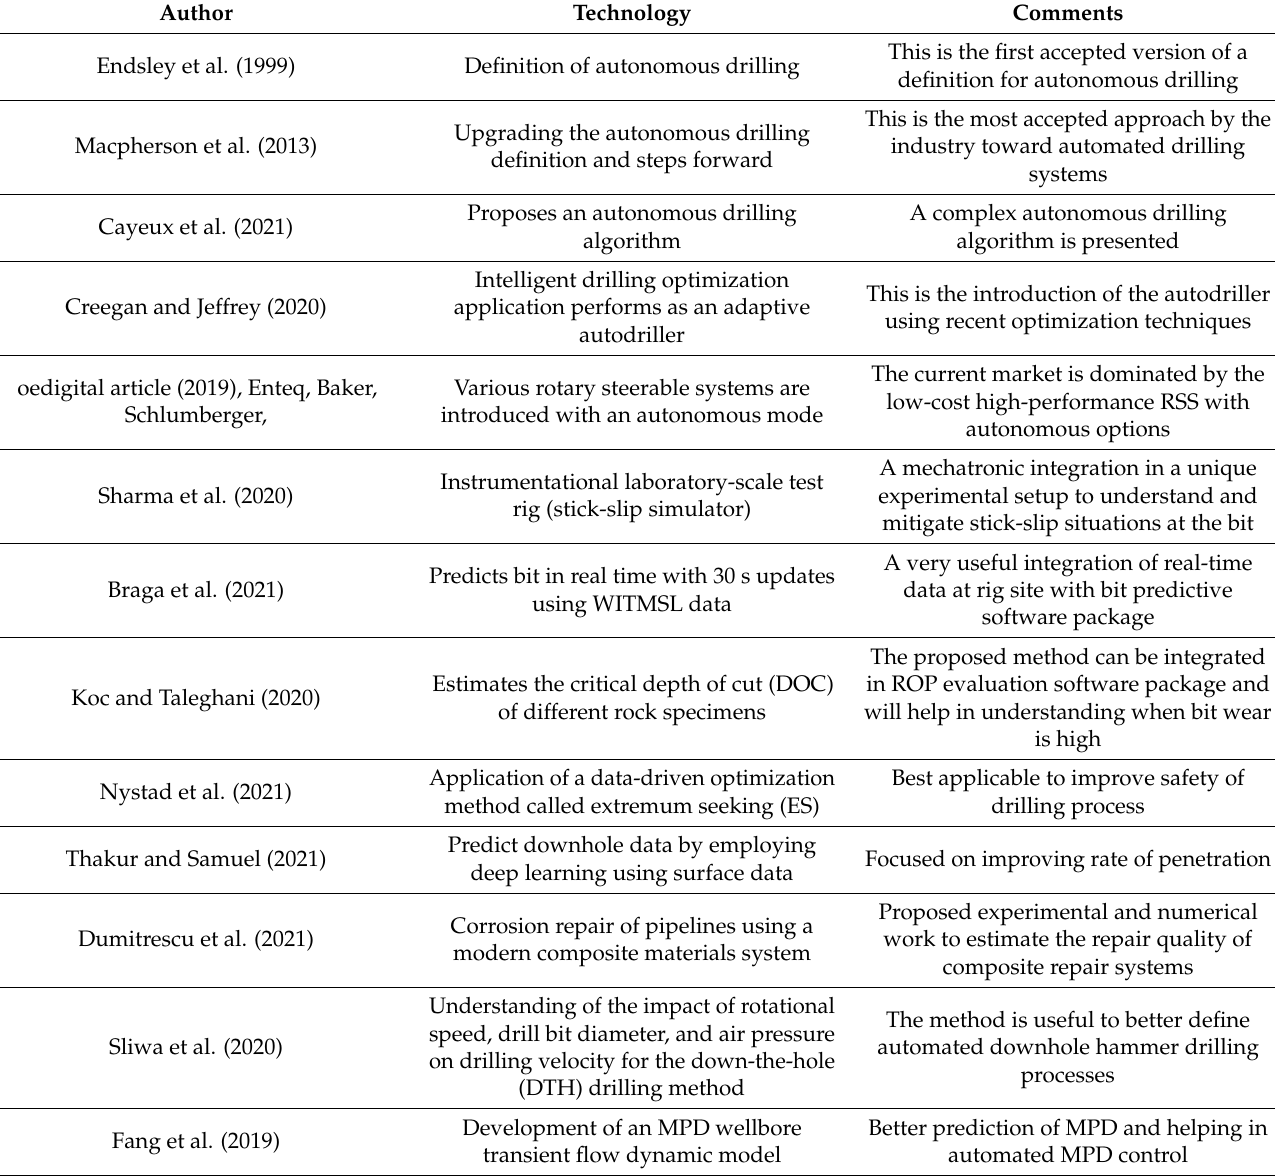
Table 1. A summary of the technologies covered in this paper is shown